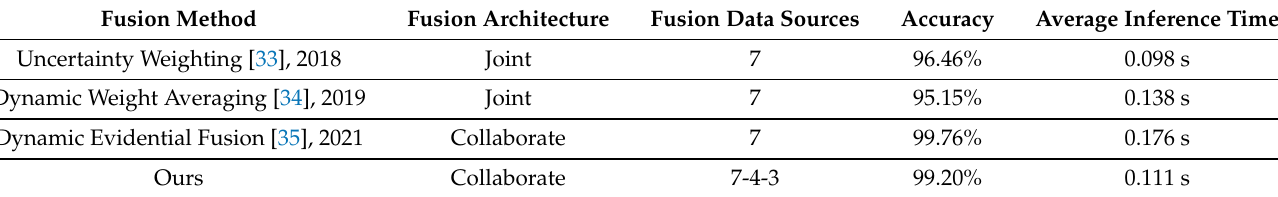
Table 6. Performance comparison between fusion